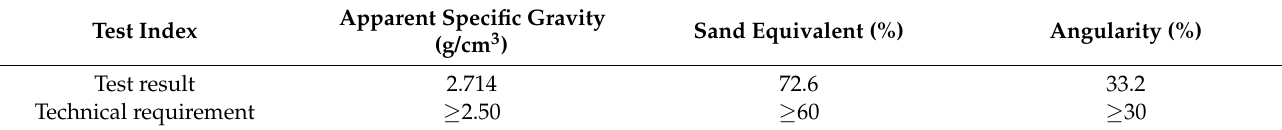
Table 5. Main technical indexes of fine